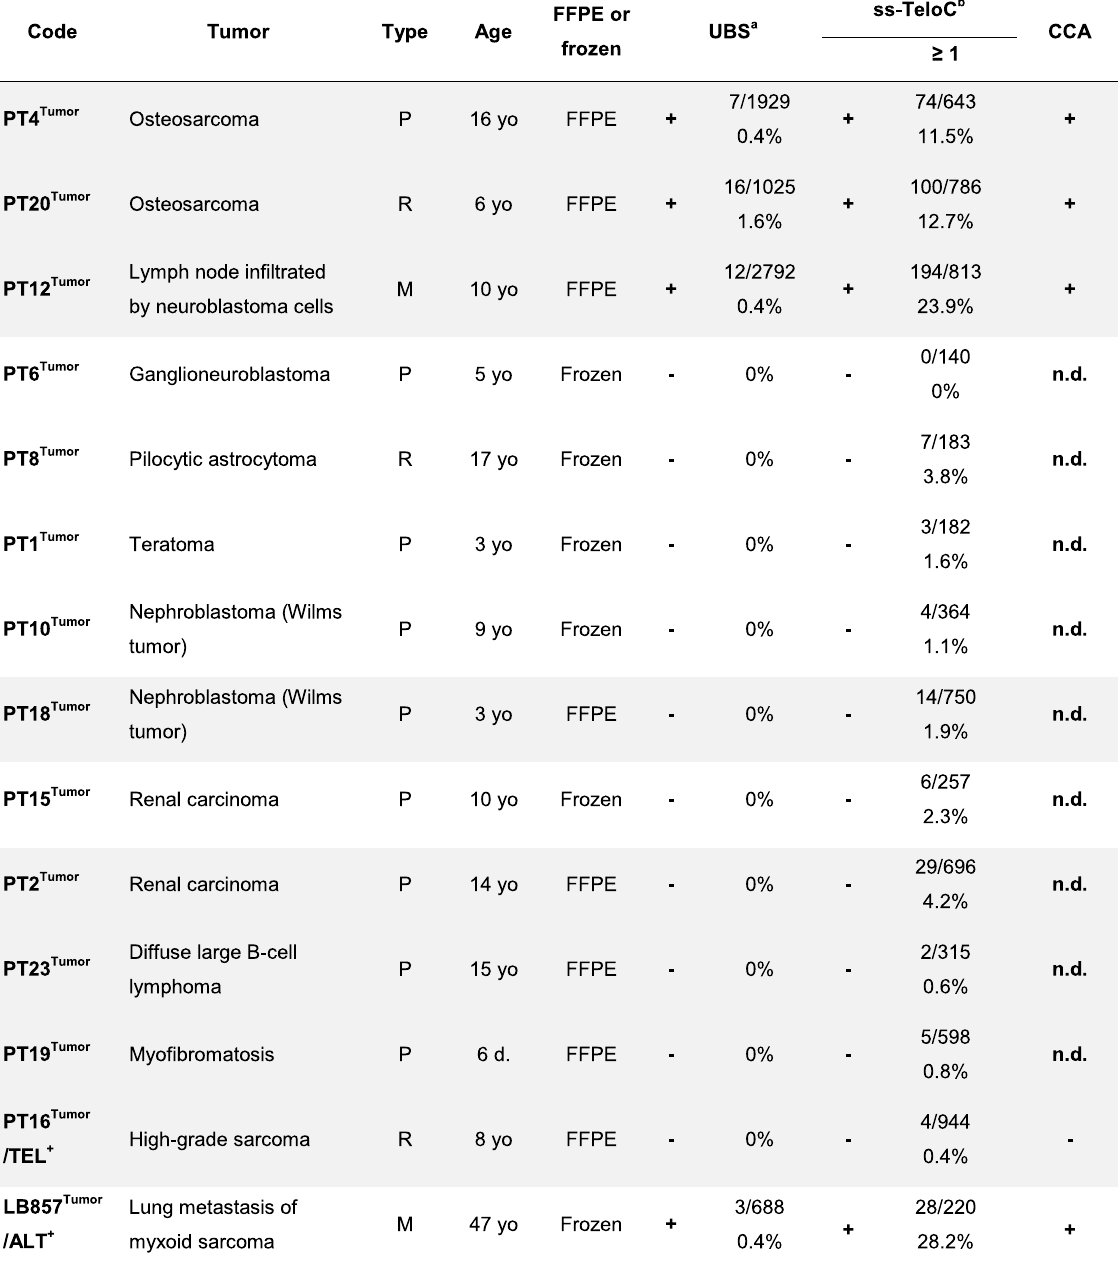
Table 2 Overview of the tumors included in this study and the results for the different markers